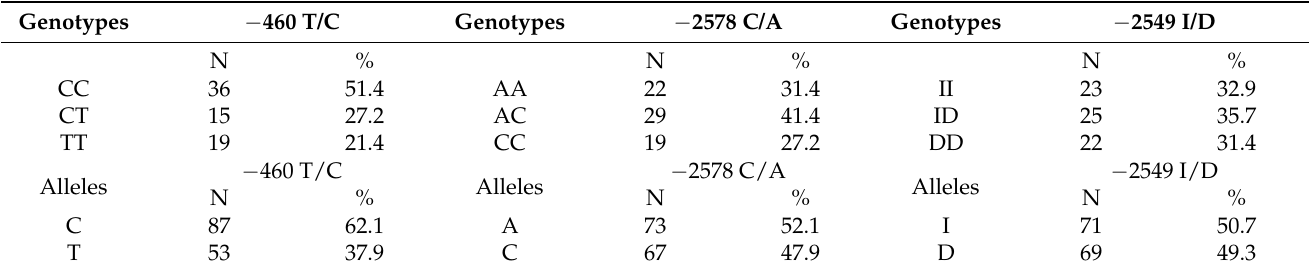
Table 3. Genotypic and allelic frequency distributions of VEGFA polymorphisms in the study population.